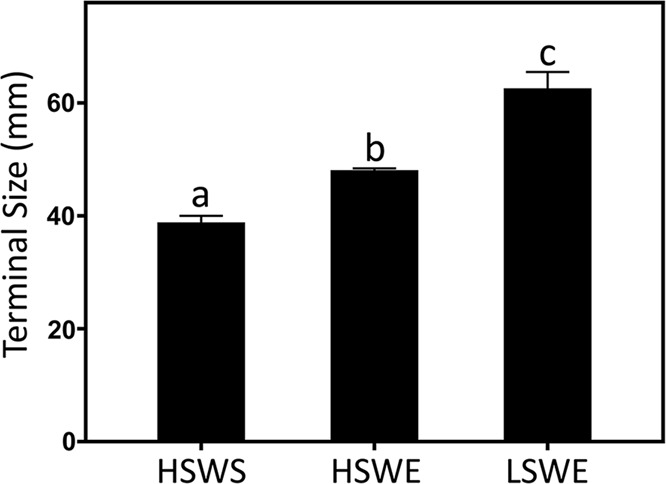
Mussel size of Crystal Cove State Park samples. Mean maximum mussel sizes from high-shore-wave-sheltered (HSWS), high-shore-wave-exposed (HSWE) and low-shore-wave-exposed (LSWE) microhabitats. Bars indicate 1 s.e. around the means. A one-way ANOVA followed by Tukey's test identified significant (P<0.05) differences in maximum sizes between groups, as indicated by letters.